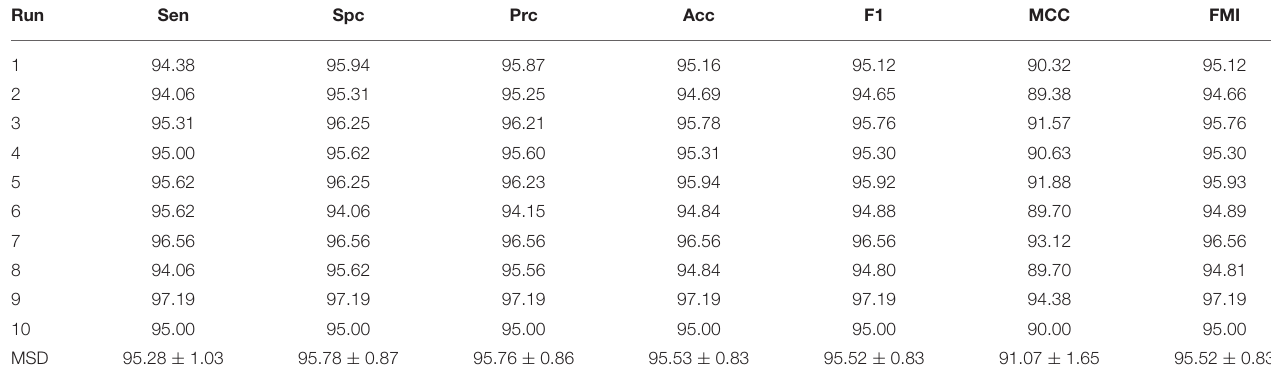
TABLE 6 | Statistical results of the proposed PSCNN